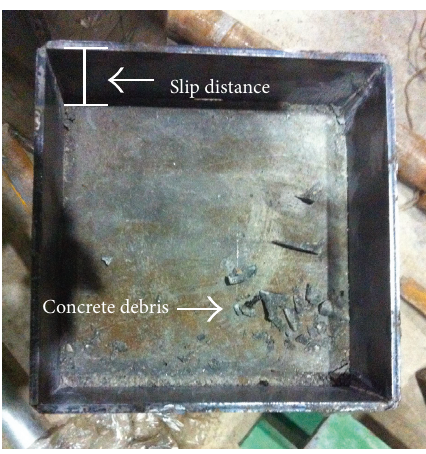
Figure 6: Failure mode of CFST4 specimen.